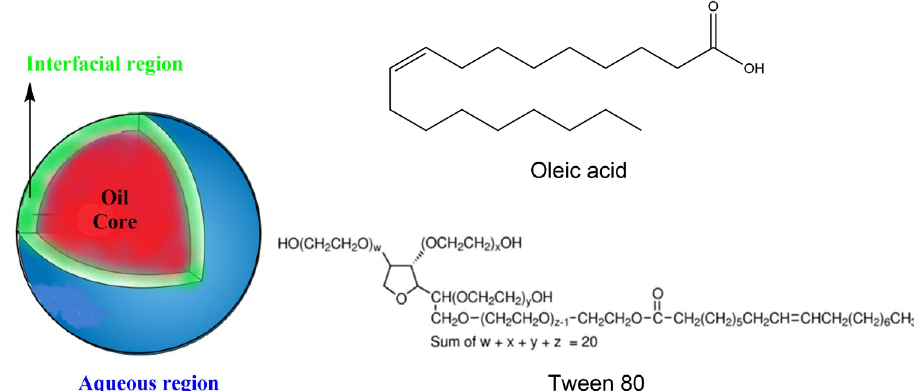
Scheme 1. ( Left ) Typical spherical droplet of O/W emulsions showing the conceptual division of the different regions (aqueous, interfacial and oil). ( Right ) Chemical structures of oleic acid and Tween 80.